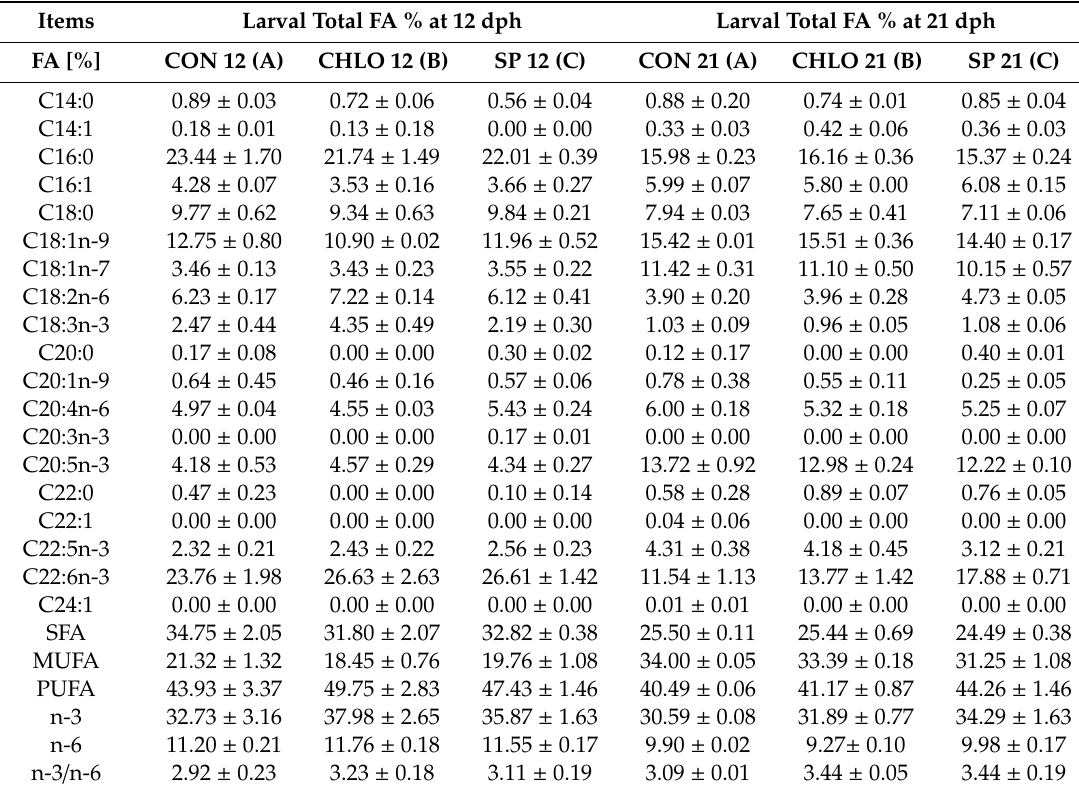
Table 2. Larvae total fatty acids percentage composition and Standard deviation ( ± ) from the three treatments (3 samples 0.05 g of larvae per treatment) after 12 and 21 days post